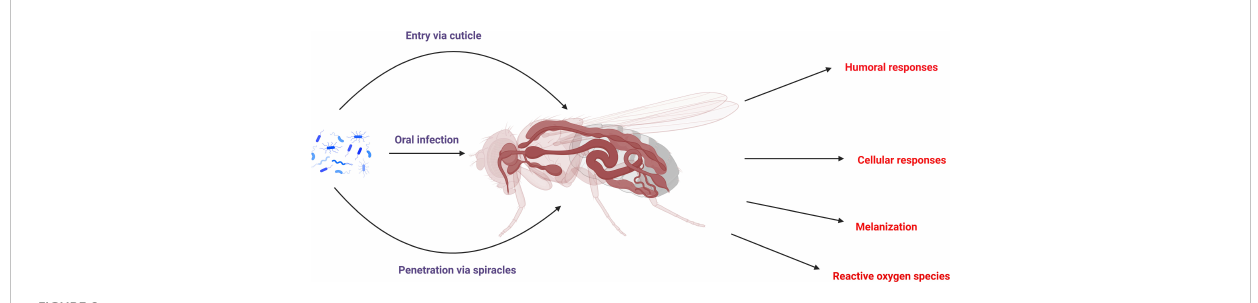
FIGURE 2 Schematic representation of the bacterial infection route in insects and also their major immune responses to bacterial